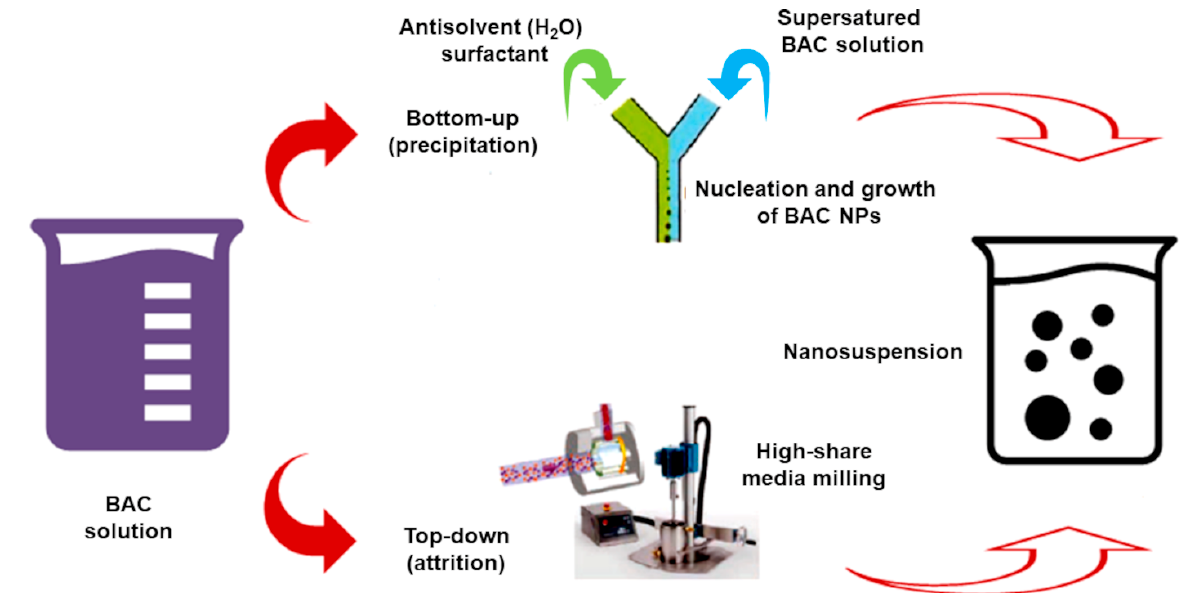
Figure 4. Bottom-up and top-down methods.